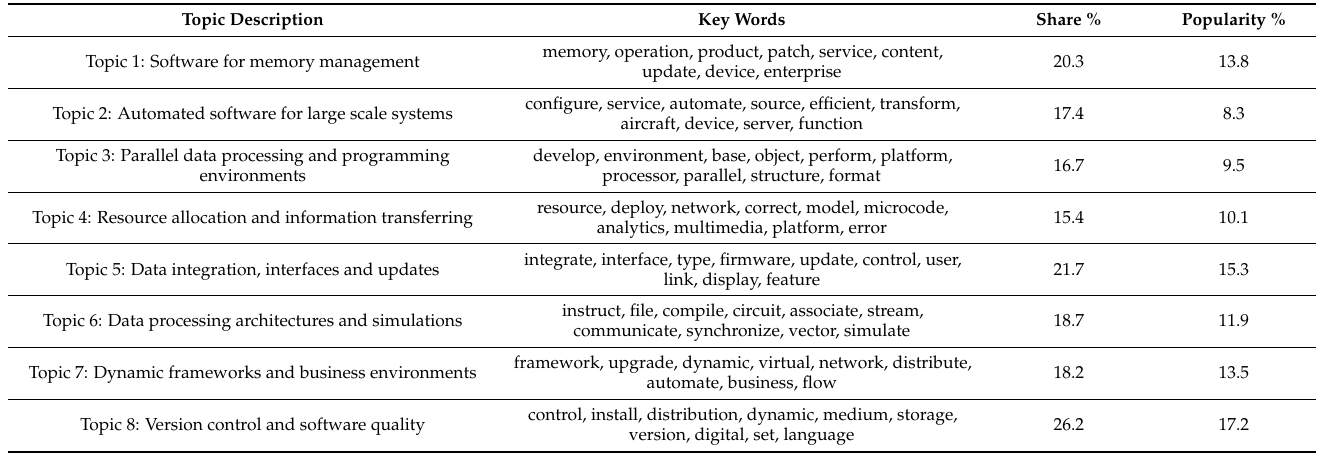
Figure 4. Inter-topic distance map. Table 7. Extracted topics and metrics.